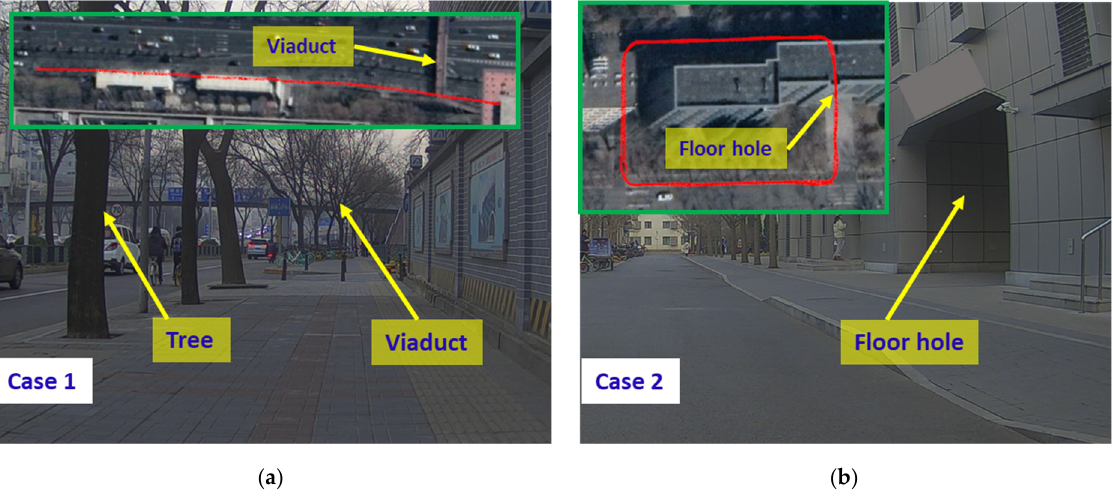
Figure 5. The experimental scenes of cases 1 and 2. ( a ) Case 1: The GNSS was slightly affected when the vehicle passed the narrow viaduct. ( b ) Case 2: The GNSS was seriously affected when the vehicle passed the wide floor hole.